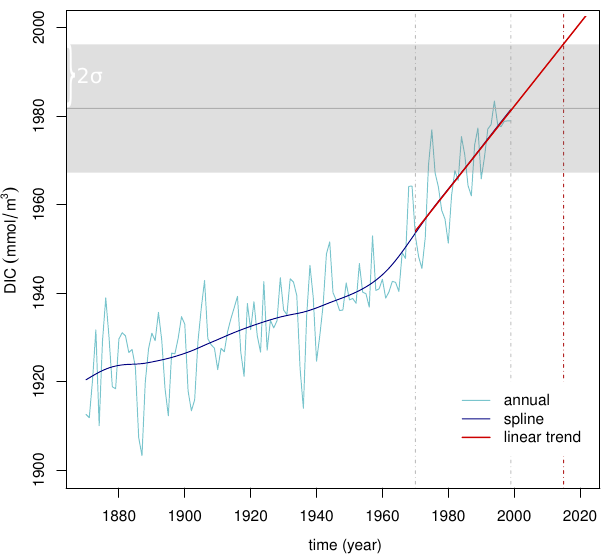
Figure 1. NCAR CESM1: annual time series (light blue), corre- sponding smoothing spline (dark blue), and linear trend (red) of dissolved inorganic carbon (DIC; mmolm − 3 ) at 22 ◦ N, 158 ◦ W, the proximate location of the Hawaii Ocean Time-series (HOT; Keeling et al., 2004). The grey bar represents two times the standard devia- tion of the detrended time series (i.e., annual-spline). The spline is calculated with a cut-off period of 40yr. The linear trend is based on the years 1970–1999 of annual, as indicated by the grey verti- cal lines. The intersect between the red vertical line and the upper border of the grey bar ( x = 2015) shows when the trend leaves the envelope of background variability and, from then on, is detectable. Consequently, the ToE at this location is 16yr